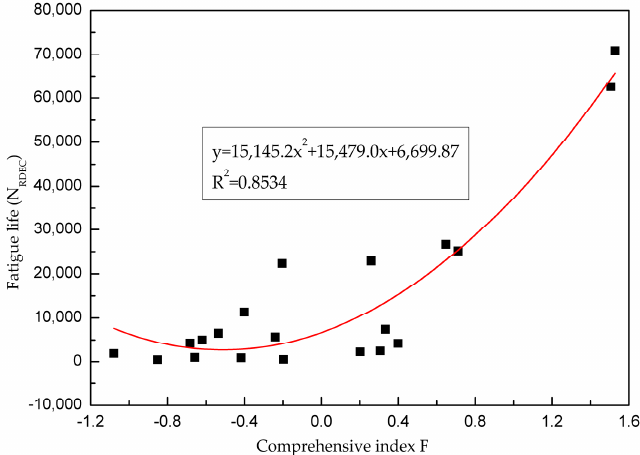
Figure 13. The fitting curve between N RDEC and F .